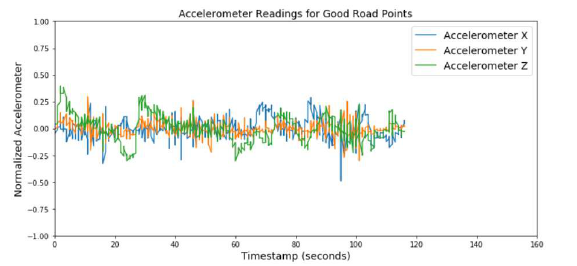
Figure 3. Accelerometer Readings for Good Road Points